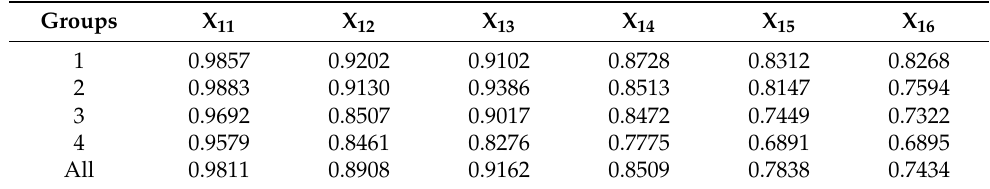
Table 4. The values of EF of regression analyses between the automatic and manual measurement of scale-invariant traits for plants with different occlusions.